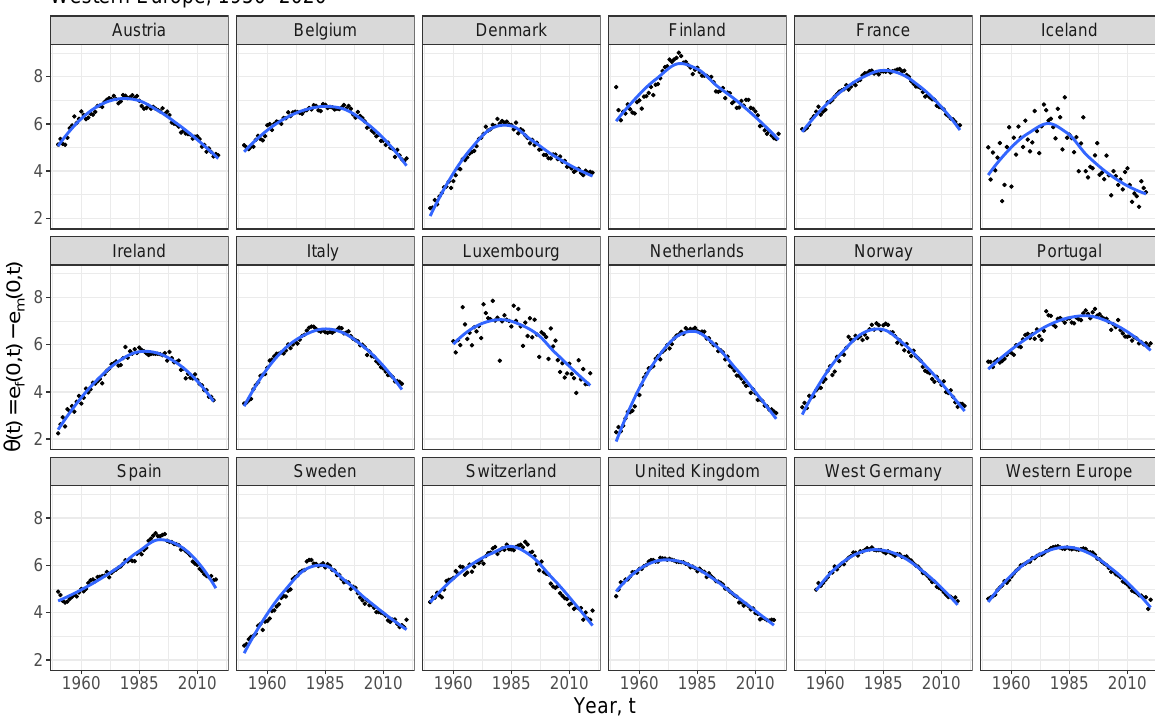
Figure 1. Life expectancy sex gap across Western Europe (black dots) with a fitted LOESS curve superimposed (blue